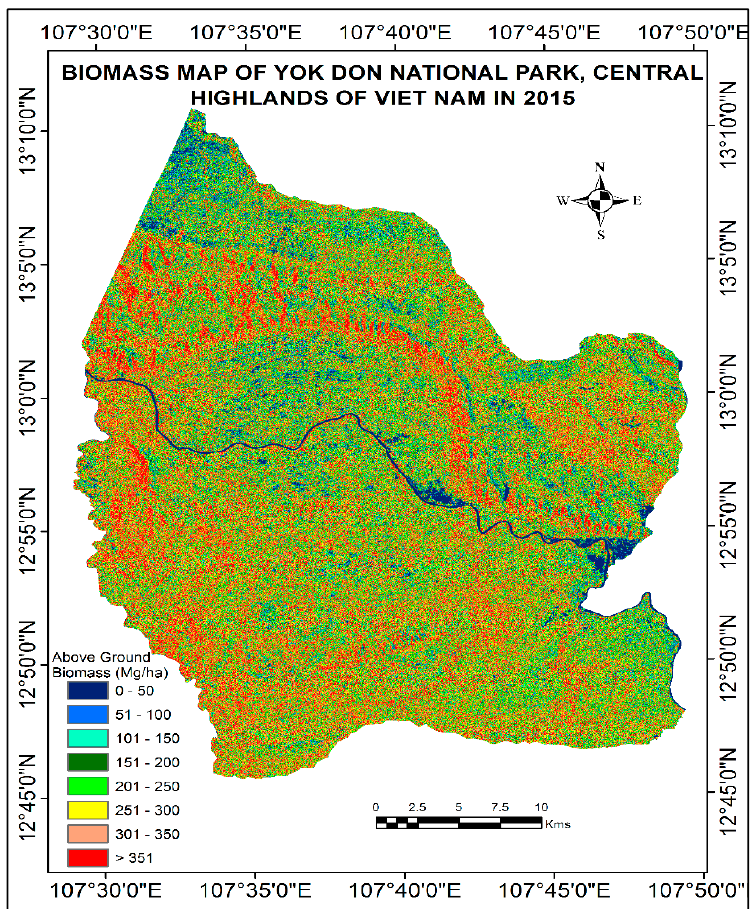
Figure 5. Biomass distribution map of Yok Don National Park, Central Highlands of Vietnam.